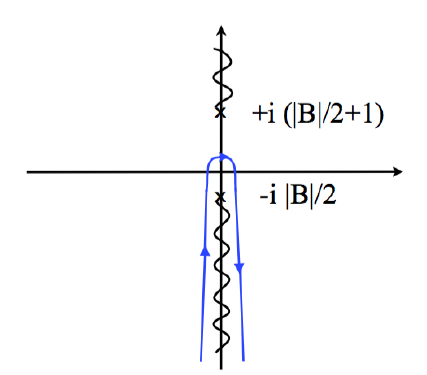
Figure 2: The contour of integration (cid:67) comes from − i ∞ − ε , circles around the branch cut and then goes back to − i ∞ + ε